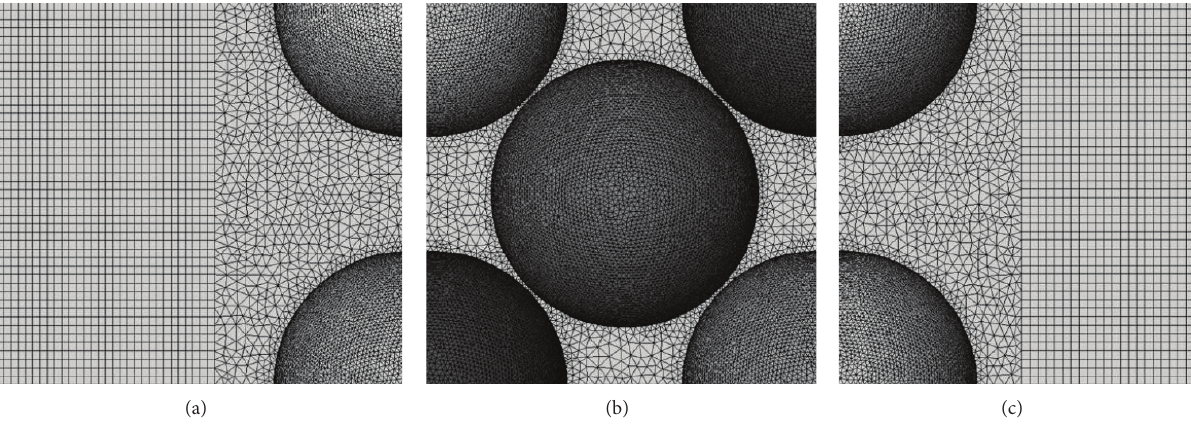
Figure 2: FCC mesh with part of inlet block, outlet block, and one cell.